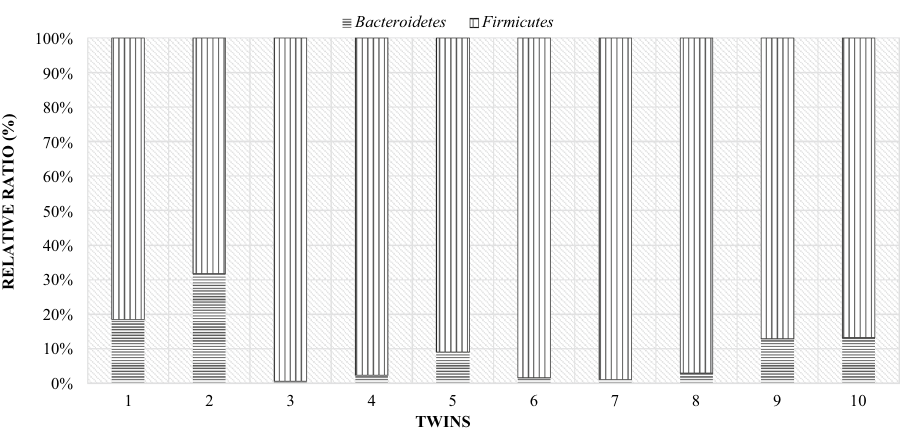
Figure 16. Relative ratio (%) of Firmicutes and Bacteroidetes phylum in lambs digestive tract at day of birth (day